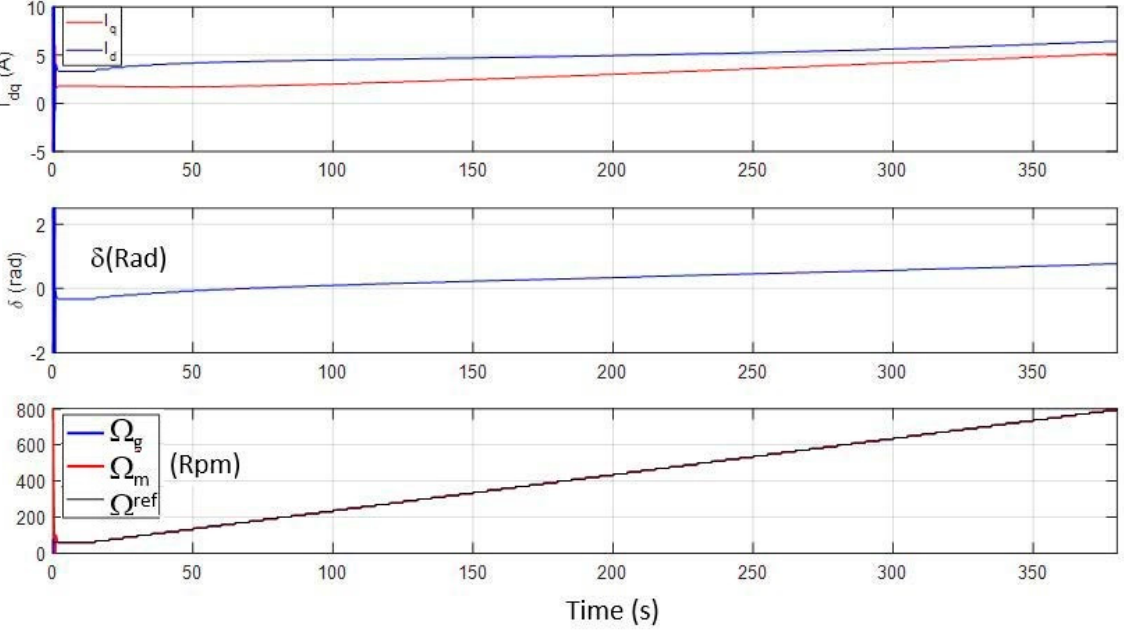
Figure 17. Time simulation result of the stability analysis for the previous coupled parametric modification with a bandwidth of 1 Hz for the generator speed control and with coupled modifications of electric and mechanical parameters.